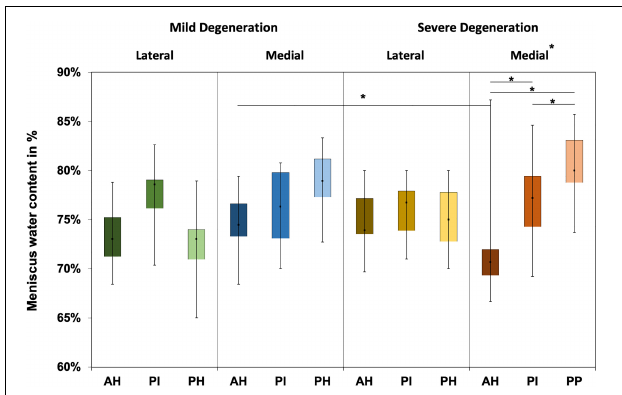
FIGURE 4 | Water content value box plots (minimum, maximum, median, and 25th and 75th percentiles) in percent of the mildly and severely degenerated menisci. Subdivided anatomical regions are: AH, anterior horn; PI, pars intermedia; PH, posterior horn. Non-parametric statistical analyses: n = 12; * p <